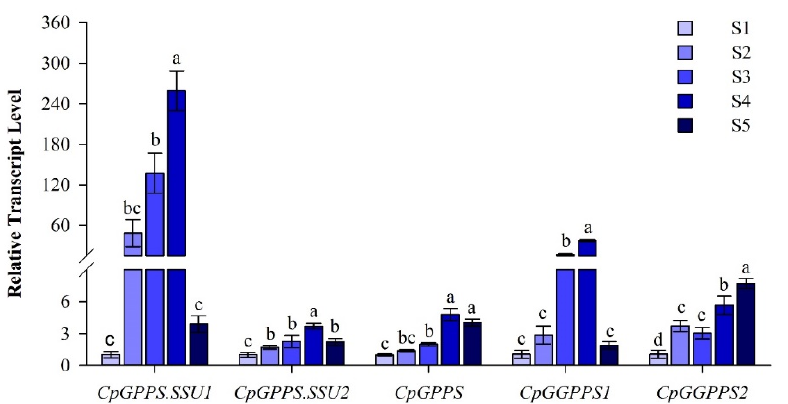
Figure 2. Spatial expression profiles of CpGPPS.SSU1 , CpGPPS.SSU2 , CpGPPS , CpGGPPS1 , and CpGGPPS2 in the wintersweet plant. β -Actin was used as a housekeeping gene to normalize gene expression.